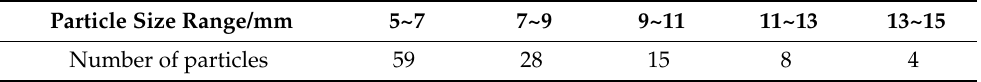
Table 2. Particle size distribution and content of aggregate in concrete.